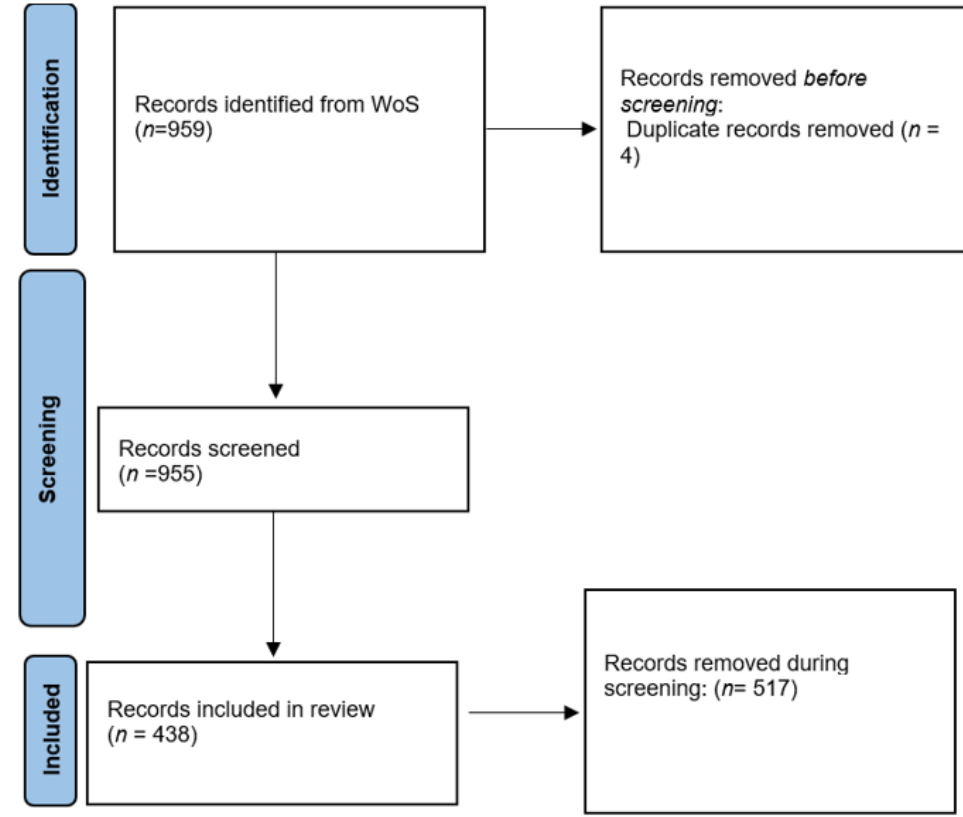
Figure 1. Process of identifying documents for study inclusion.